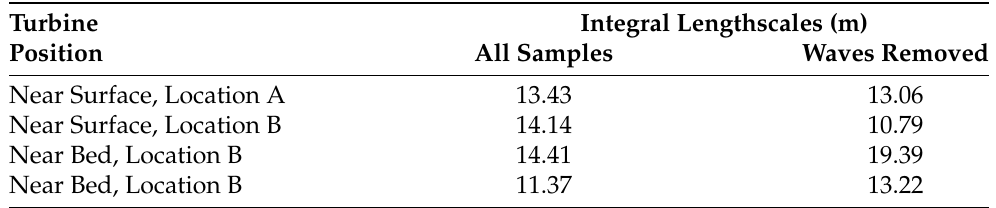
Table 3. Integral lengthscales calculated from measured data for one flow speed case, for all samples and with wave cases removed.